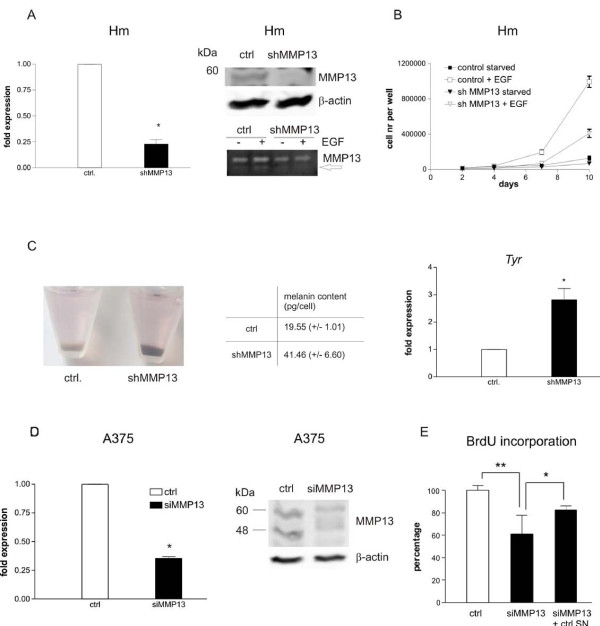
MMP13 knockdown in murine melanocytes and the human melanoma cell line A375 reduces proliferation. A, left: Realtime-PCR of Mmp13 expression in melan-a Hm cells transgenic for a control pRetroSuper vector (ctrl.) compared to melan-a Hm cells expressing pRS-shMmp13. A, right, top: Western blot displaying the decrease of the pro-form of MMP13 after knockdown in murine melan-a Hm cells. Note that only the human, but not the murine active form is recognized by the antibody (also see D). A, right, bottom: Zymography of unconcentrated supernatant, showing a decreased MMP13 band after knockdown. B: Starved melan a Hm pRS and Hm pRS-shMmp13 cells were stimulated with EGF, and cell proliferation was measured after 2, 4, 6, 8 and 10 days. C, left: Appearance of cell pellets of EGF-stimulated Hm cells either transfected with the control vector or the pRS-shMmp13 vector. C, middle panel: Quantification of melanin in EGF-stimulated Hm cells either transfected with the control vector or the pRS-shMmp13 vector. C, right: Realtime PCR analysis of tyrosinase transcript levels in control Hm cells and Hm cells expressing pRS-shMmp13. β-actin was used as reference gene. D, left: Realtime-PCR of MMP13 expression in A375 cells transfected with siRNA against MMP13 or an siRNA control, 72 h after transfection. D, right: Western blot of MMP13, showing the full-length (60 kDa) and the active (48 kDa) form of the protein in A375 cells treated with control or MMP13-specific siRNA. E: BrdU incorporation of A375 cells transfected with control siRNA or MMP13-specific siRNA. The right bar shows the BrdU incorporation of A375 cells, treated with MMP13-specific siRNA, but in presence of the 48 h-conditioned supernatant from control siRNA-transfected cells. BrdU incorporation of the control cells is used as reference and is set as 100%. The assay was performed three times independently. *: p < 0.05 (Student's t test, paired, two-tailed)